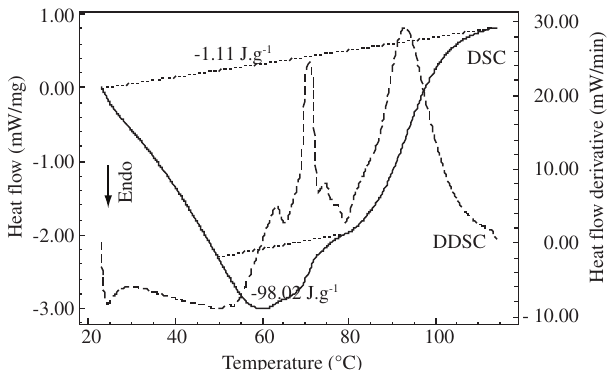
Figure 2. DSC/DDSC curves obtained in dynamic N (50 mL.min -1 ) and heating rate 10 °C.min -1 of GA cross-linked bovine peri- cardium